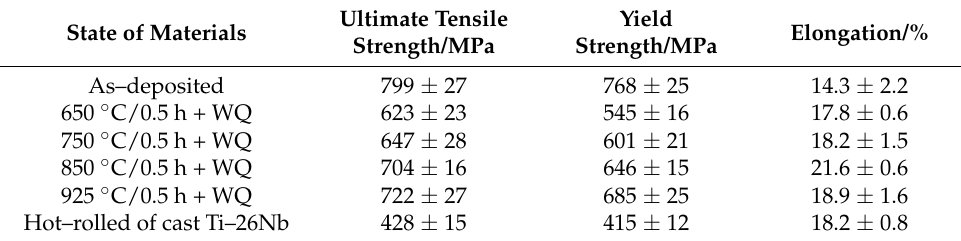
Figure 13. Mechanical properties of Ti–26Nb alloys after annealing at different temperatures. Table 2. Mechanical properties of Ti–Nb alloys fabricated by LAM and casting. State of